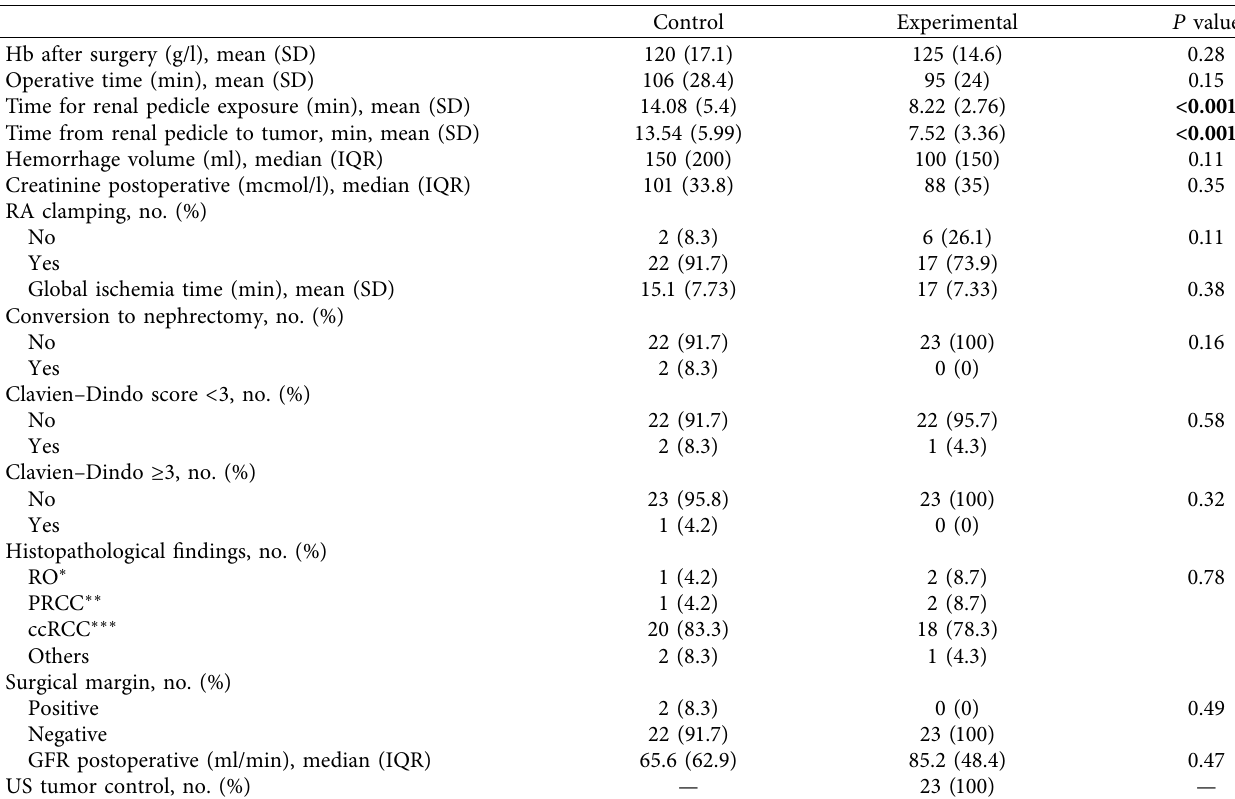
Table 2: Intra and postoperative variables.